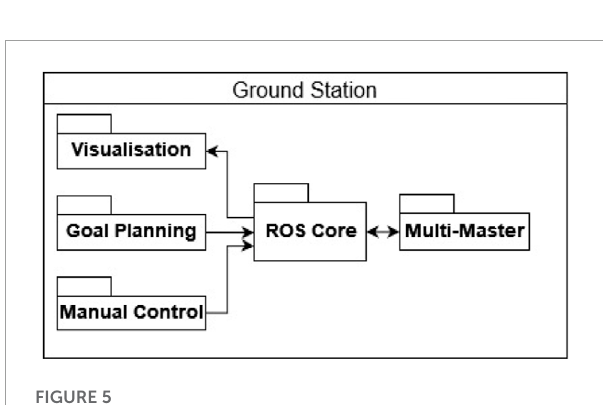
FIGURE 5 REALMS ground station architecture diagram showing commands sent to the robot and visualisation based on data received by the rover.